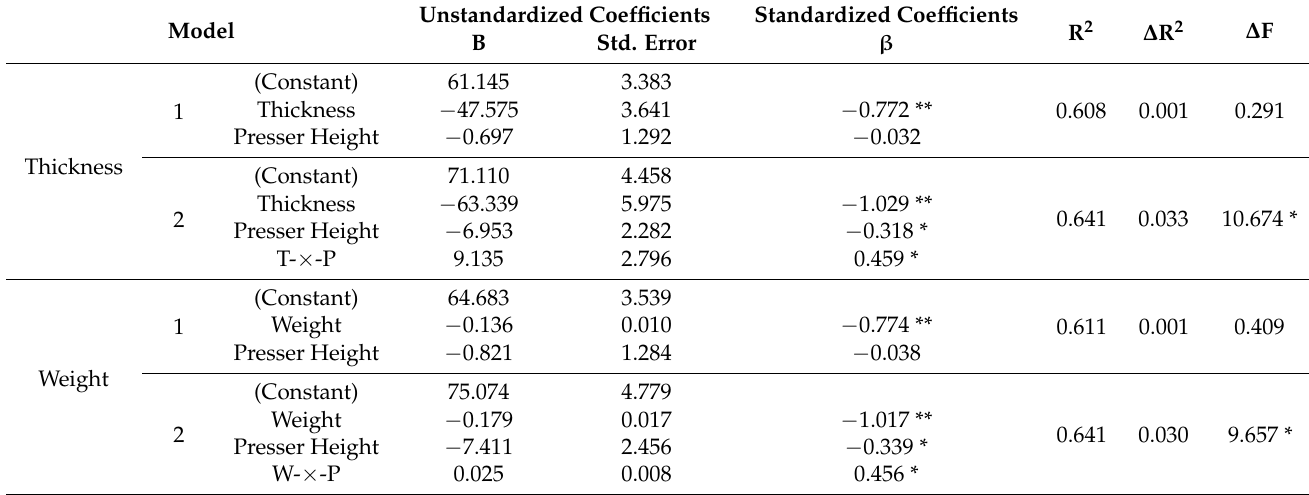
Table 9. Moderated multiple regression analysis predicting seam strength in the lock stitch pattern. Model